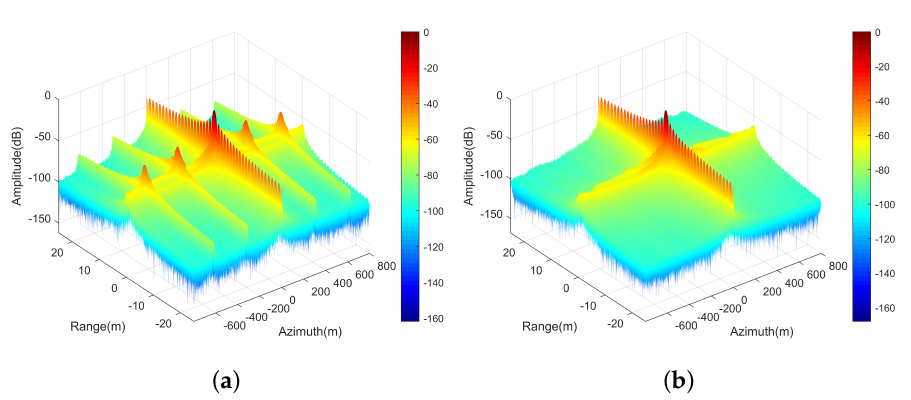
Figure 10. Imaging results of the point target with nonconstant channel spacing error. ( a ) Reconstruc- tion result by IDR; ( b ) reconstruction result by SILAMER.